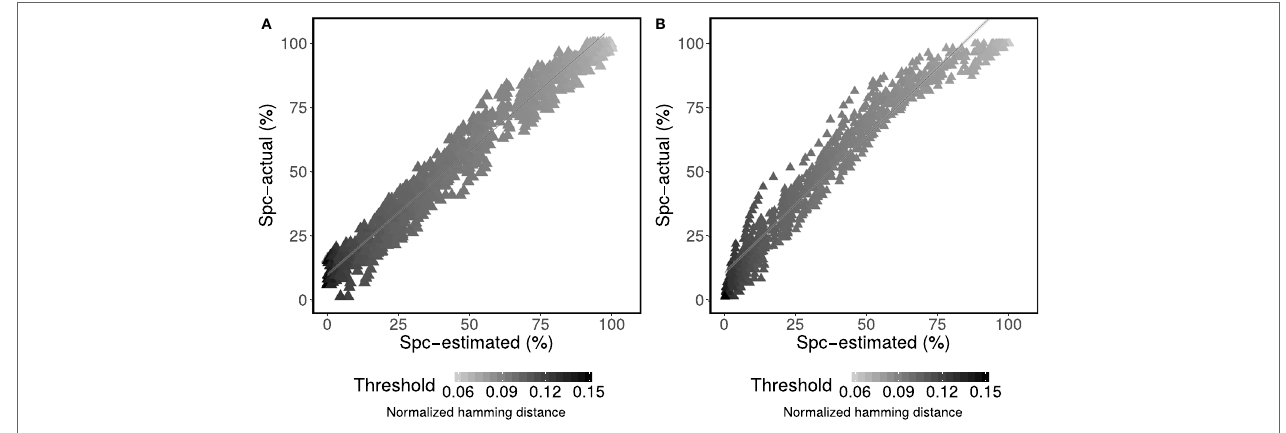
FIGURe 3 | Performance assessment of specificity (Spc) for determining membership in a multi-sequence clone. Mixture modeling of the distance-to-nearest distribution was used to estimate specificity for each specified value of the threshold (points) according to equation set 2. (A) The estimated performance was compared with actual performance for experimental data from patients with acute dengue infection (10) across a wide range of thresholds (shades of gray for each point). (B) The estimated performance (Spc-estimated) was compared with actual performance (Spc-actual) across two independent experimental studies (6, 10) across a wide range of thresholds (shades of gray for each